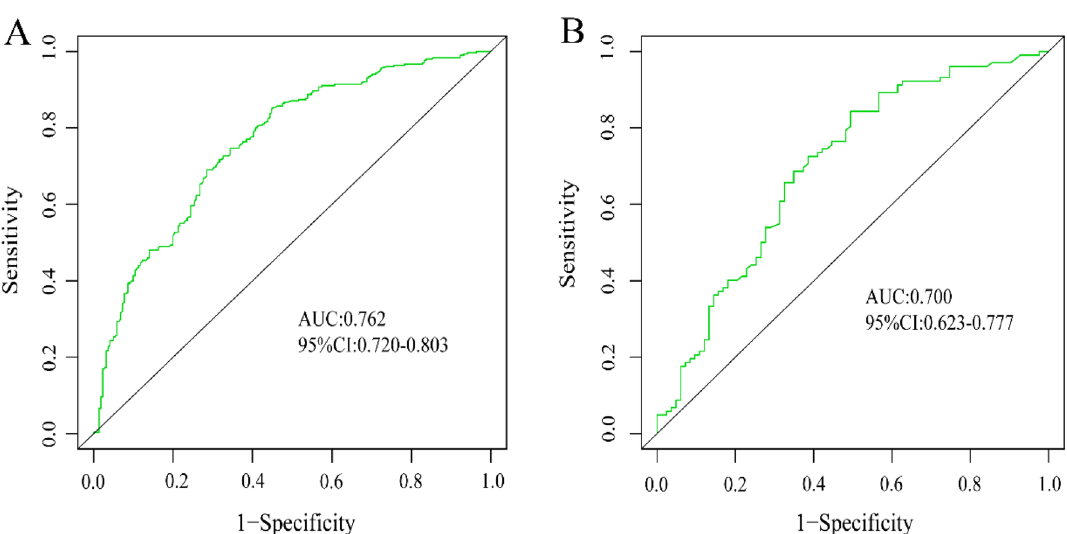
Figure 6. The ROC curves of the nomogram model. ( A ) indicates the ROC curve of the training set, and ( B ) indicates the ROC curve of the validation set. The x-axis represents 1-specificity, and the y-axis represents sensitivity. The part below the green line is the area under the ROC curve of the